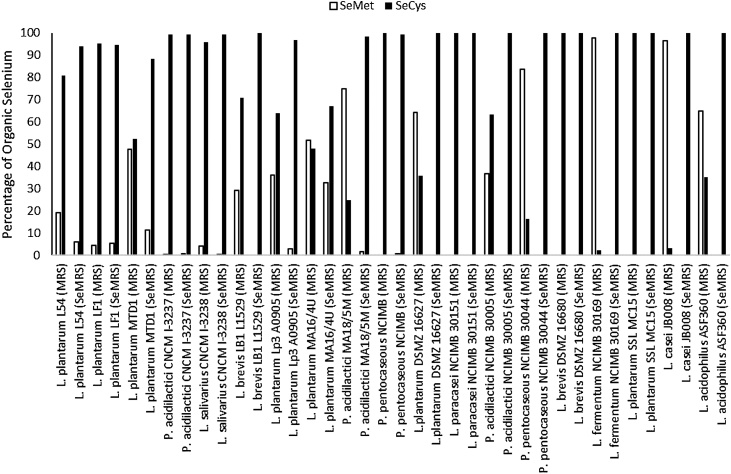
Percentage of total organic selenium as Selenomethionine and Selenocysteine of isolates cultured in MRS broth with sodium selenite (SeMRS) and without (MRS).